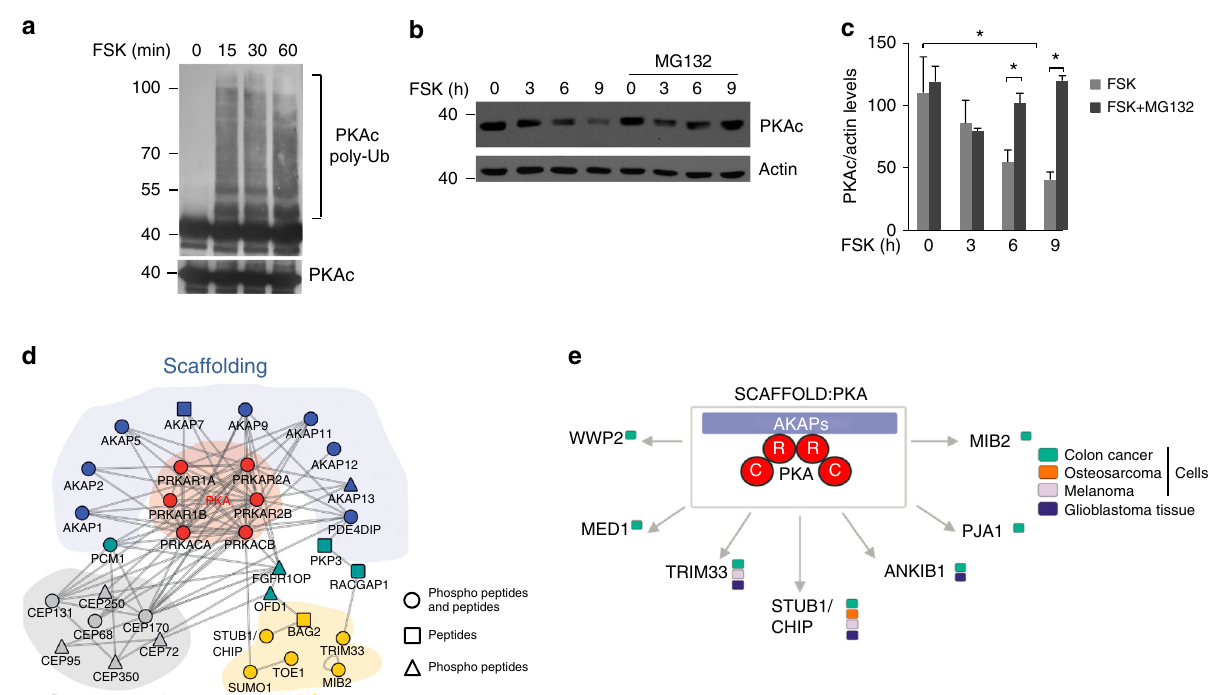
Fig. 1 cAMP stimulation induces ubiquitylation and proteolysis of PKAc. a Cells were transiently transfected with HA-ubiquitin. Twenty-four hour after transfection, cells were treated with MG132 (20 µ M) for 1 h and then stimulated with FSK (40 μ M) for the indicated time points. Lysates were subjected to immunoprecipitation with anti-PKAc. The precipitates were immunoblotted with anti-PKAc and anti-HA antibodies. b HEK293 cells were serum deprived overnight and then stimulated with forskolin (FSK 40 μ M). Where indicated, cells were pretreated with the proteasome inhibitor MG132. Cells were, then, harvested at the indicated time points and lysed. The lysates were immunoblotted with the indicated antibodies. c Quantitative analysis of the experiments shown in b . A mean value ± S.E.M. of four independent experiments is reported; Student ’ s t test, * p < 0.05. d Illustrated are selected protein interactions of macromolecular PKA complexes following af fi nity puri fi cations from a collection of cancer cells and glioblastoma tissue. Following gene ontology (GO) annotations, the whole dataset was used to extract functionally linked complexes (color coded). Selected subnetworks linked to PKA complex formation, kinase scaffolding, centrosome function, and the ubiquitin-proteasome system are depicted. The shape of listed icons indicates mode of identi fi cation in the MS/MS analyses. e Shown are proteins from the UPS identi fi ed upon af fi nity isolations of endogenous PKA complexes from different cell/tissue